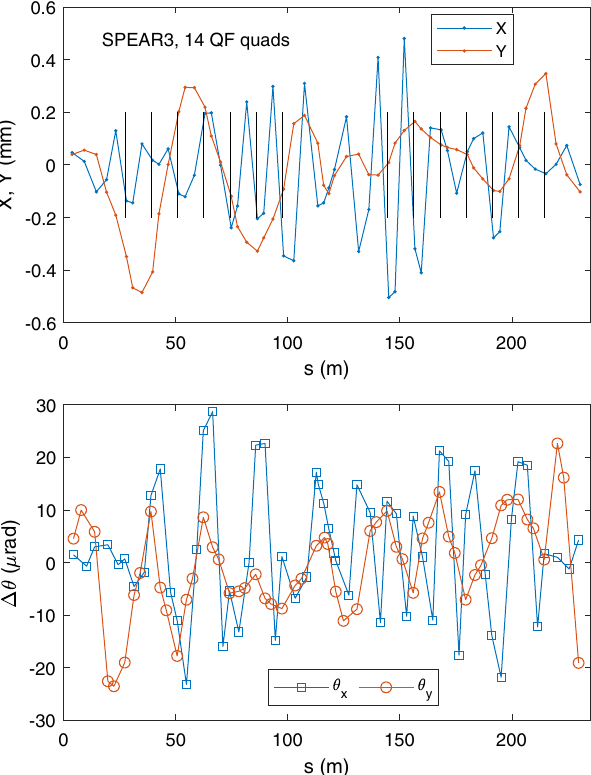
FIG. 9. Top: the beam orbit after correction of the IOS for the SPEAR3 example. The locations of the quadrupoles in the BBA group are marked with vertical lines. Bottom: the corresponding corrector kick angles.